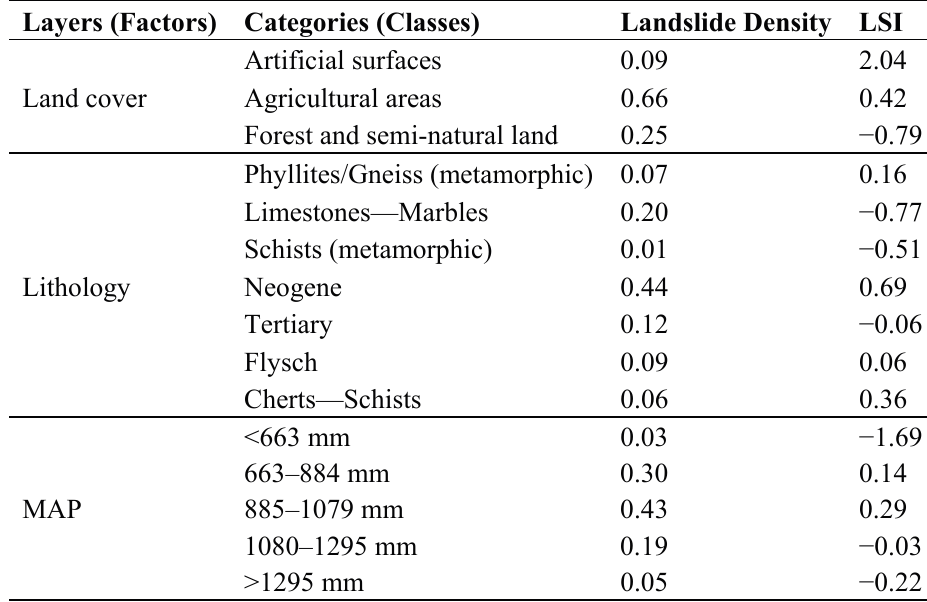
Table 1. Categories, landslide densities and susceptibility values (LSI) for landslide related